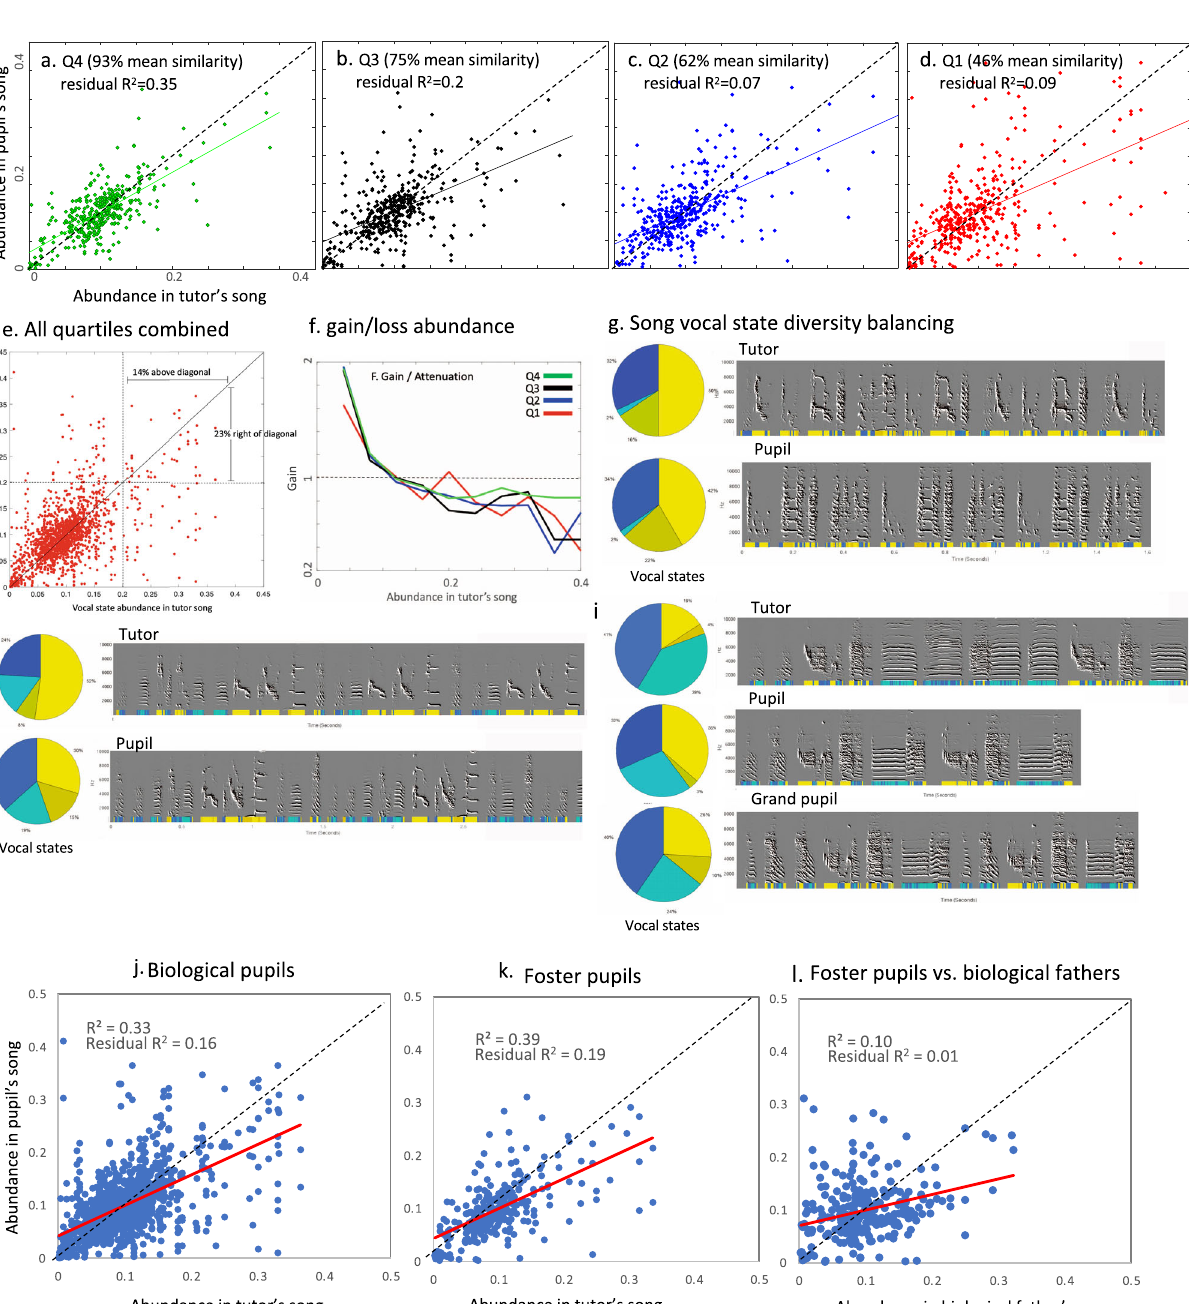
Fig. 6 Imitation of vocal state abundances. a – d Scatter plots of tutor vs. corresponding pupil vocal state abundances according to quartiles of song similarities. Note that each bird is represented by 10 markers, which are not statistically independent. The residual correlations were computed after removing trends with bird identities included as random factors. Dashed lines are identity, slope = 1. Colored lines are regression of the data. e Same data as in a – d combined, comparing vocal states abundances > 20% in tutor vs. pupil songs. f Median imitation gains for all state abundances, according to imitation quartiles. Gain of 1 indicates no bias, gain of 2 indicates doubling of abundance, and gain of 0.5 halving. Y axis is log-scale. g – i Examples of song diversity balancing. We simpli fi ed the 10 vocal states into 4 groups: yellow for high pitch states 9 – 10; mustard for medium pitch, high entropy states 6 and 8; light blue for non-modulated states 4 and 7; and dark blue for the rest 1, 2, 3, and 5. In i , we present two generations of pupils. Note the more uniform pie charts in pupils compared to their tutors. j , Vocal state abundances in biological tutors vs. pupils ’ songs. k Vocal state abundances in foster tutors vs. pupils ’ songs. l Vocal state abundances in fostered pupils vs. their biological fathers, who did not raise them, which did not raise them. Dashed lines are identity, slope = 1. Red lines are regression of the data. Source data for this fi gure is in Supplementary Data File